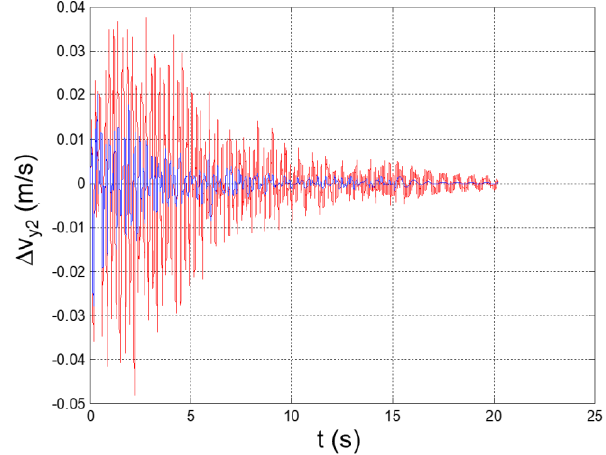
Figure 37. Seismic response, interstory speed at the 2nd floor ( Δ 𝑣 y2 = 𝑣 y2 − 𝑣 y1 ).